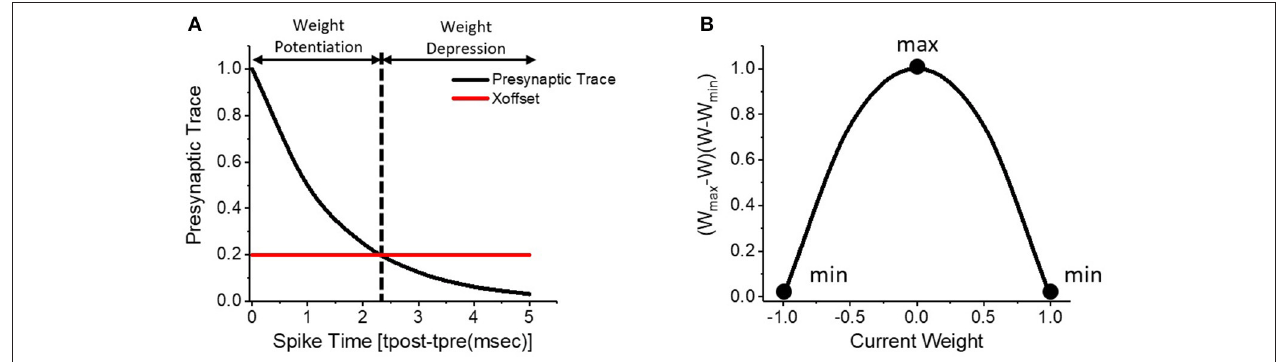
FIGURE 2 | (A) Weight-dependent positive-STDP learning rule, where the synaptic weight is potentiated for strong timing correlation between the pre- and post-synaptic spikes and depressed for larger spike timing differences. (B) Illustration of the non-linear weight-dependent updates to the synaptic weight.